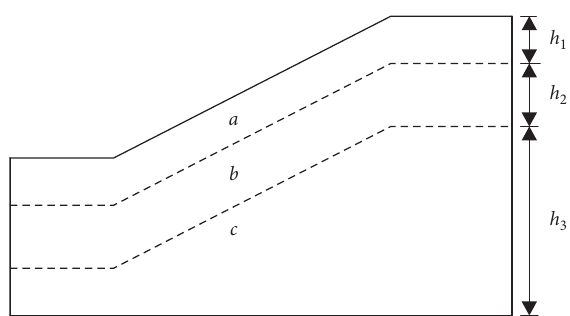
Figure 6: Section of dispersive soil for slope stability